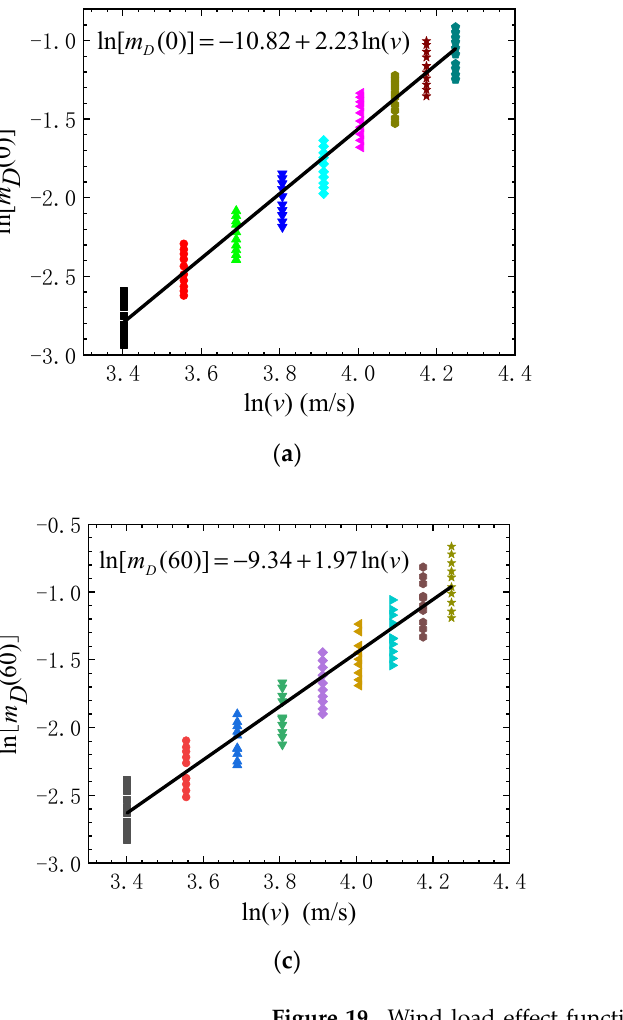
Figure 19. Wind load effect functions of the transmission tower under different corrosion ages: ( a ) 0 year; ( b ) 30 years; ( c ) 60 years; ( d ) 90 years.